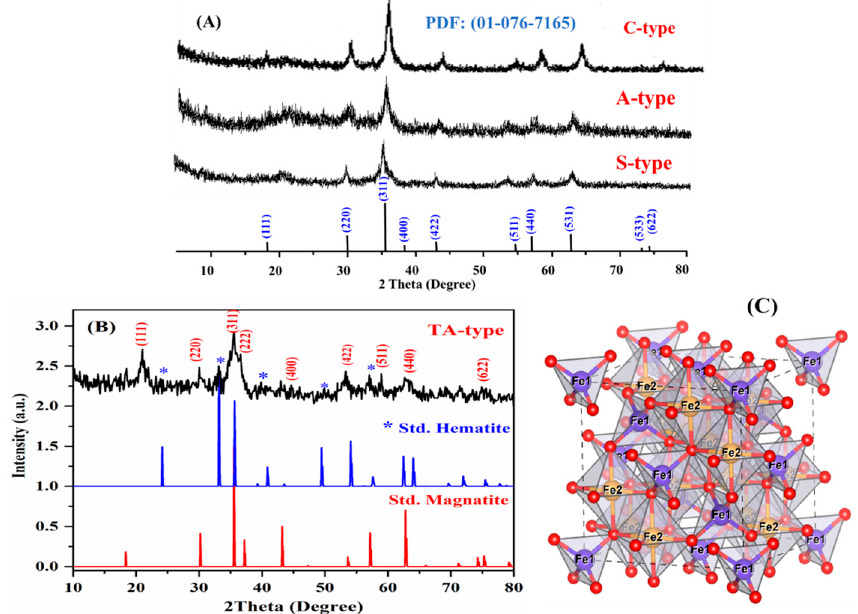
Figure 2. XRD analysis of the four different nanohybrids ( A , B ). The bar-type spectrum depicts the standard magnetite and hematite pattern ( B ). The spinel structure’s unit cell crystal structures ( C ).